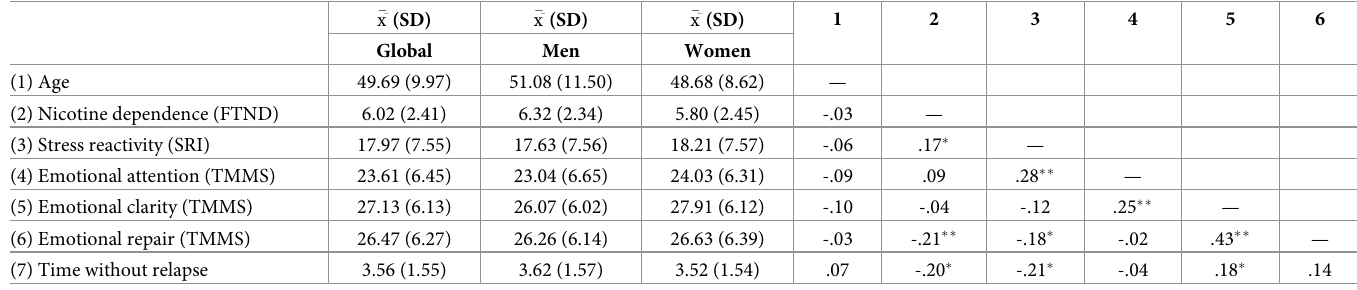
Table 1. Descriptive statistics and Pearson correlation matrix of variables included in the study. Data from the TMMS, SRI, and FTND questionnaire were collected prior to the smoking cessation intervention. � x � (SD) � x � (SD) � x �